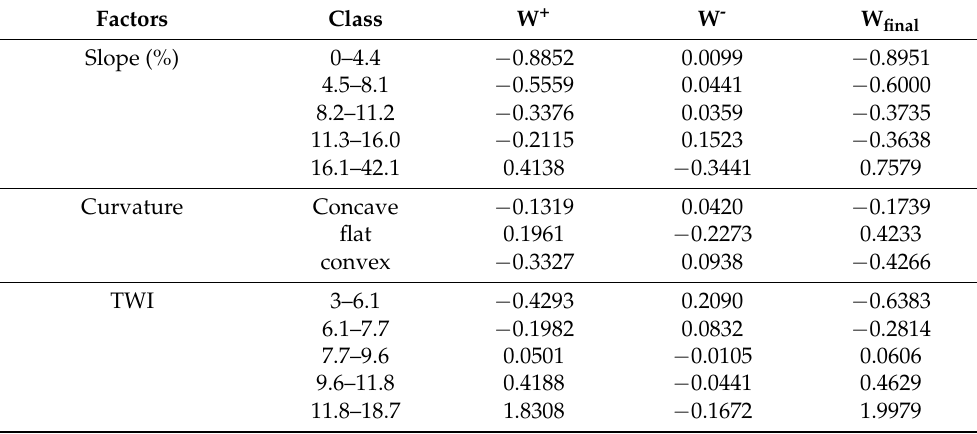
Table 2. Weights of conditioning factors Slope, Curvature, TWI, Distance to stream and Distance to road as analyzed using WoE